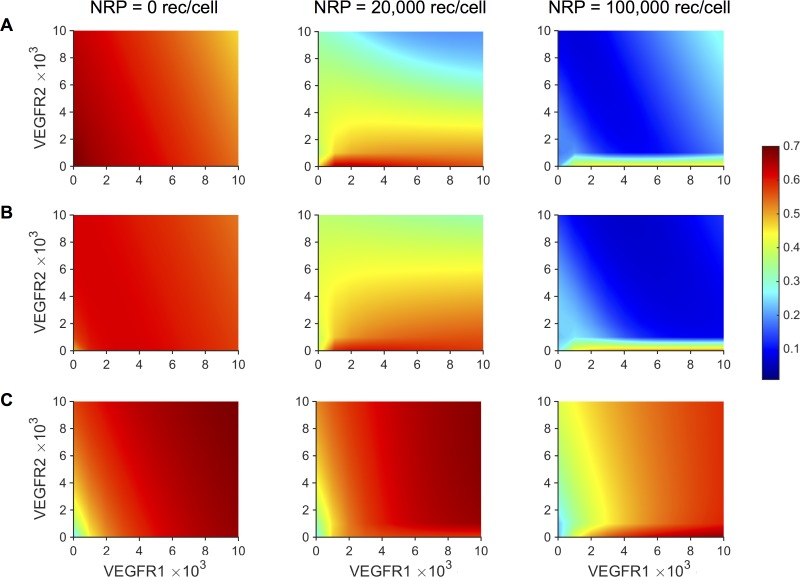
Effect of VEGF receptor expression on tumor cells.Relative tumor volume (RTV) predicted by the model using optimized parameter values obtained from fitting: A, Roland [34]. B, Zibara [35]. C, Volk 2008 [37], for different VEGF receptor levels on tumor cells. Neuropilin density varies: 0 receptors/cell (left), 20,000 receptors/cell (center), and 100,000 receptors/cell (right). Contour plots reveal the relationship between RTV and VEGFR1, VEGFR2, and neuropilin receptor density on tumor cells. The colorbar indicates the RTV value, with the same range for all panels. Red color indicates higher RTV, representing tumor conditions that are less favorable for anti-VEGF treatment.